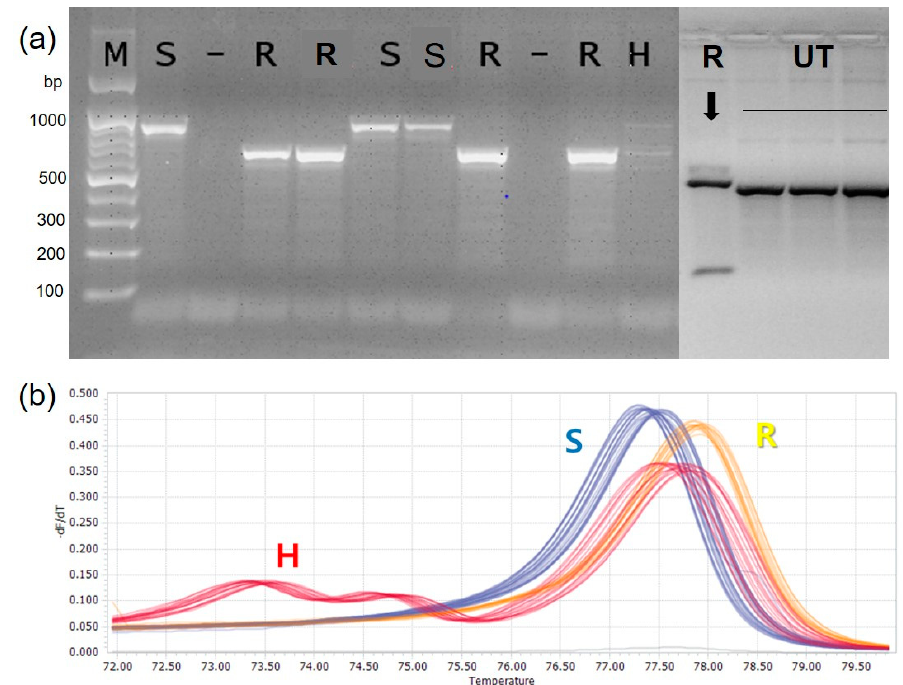
Figure 4. Examples of CaR12.2M1-CAPS Marker ( a ) and CA12g19240 HRM marker analysis ( b ). The CaR12.2M1-CAPS Marker analysis showed four types of genotype: resistant (R), susceptible (S), heterozygous (H) and Unidentified type (UT) along with 100 bp DNA size marker (M). The normalized melting peaks generated by CA12g19240 HRM marker analysis showed three types of genotypes: resistant (R), susceptible (S) and heterozygous (H).